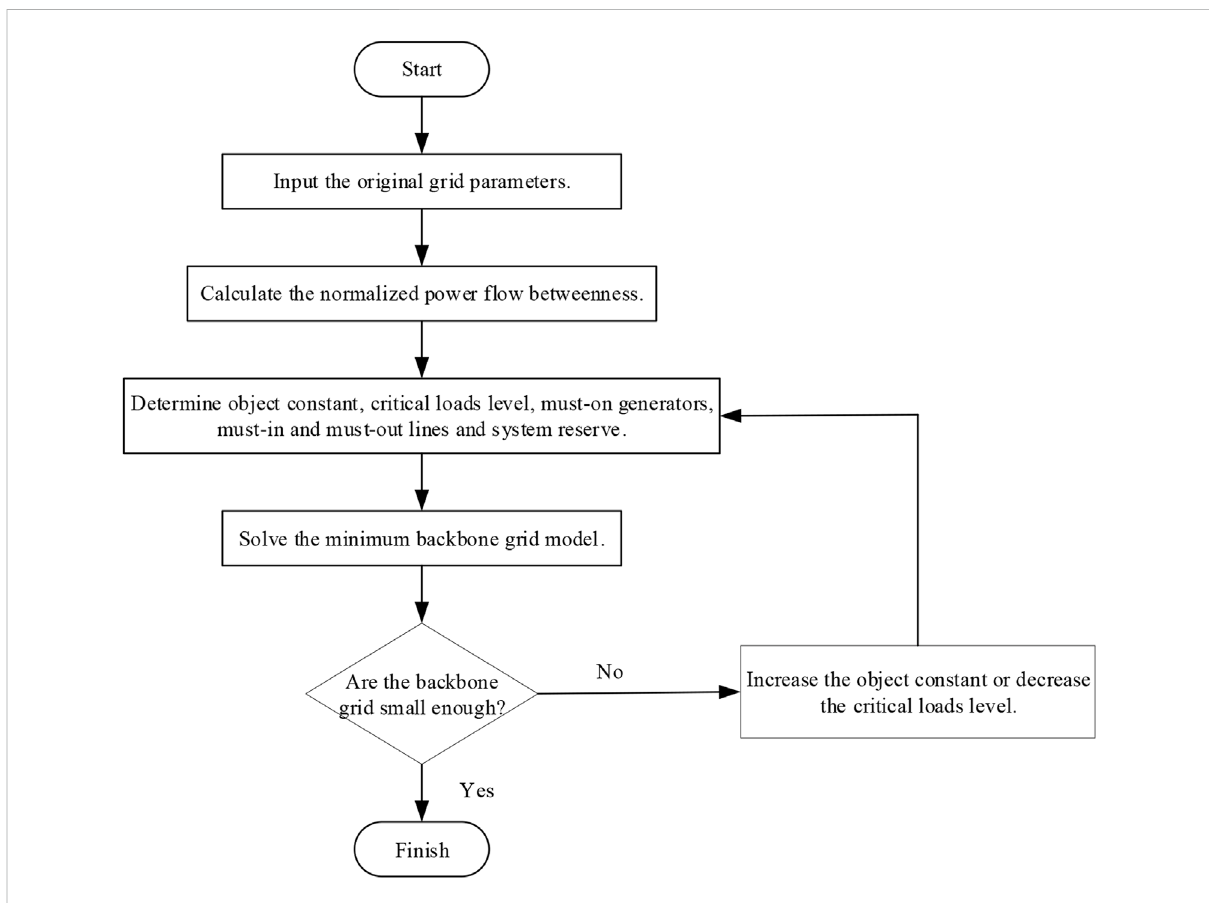
FIGURE 1 Implementation fl owchart of minimum backbone